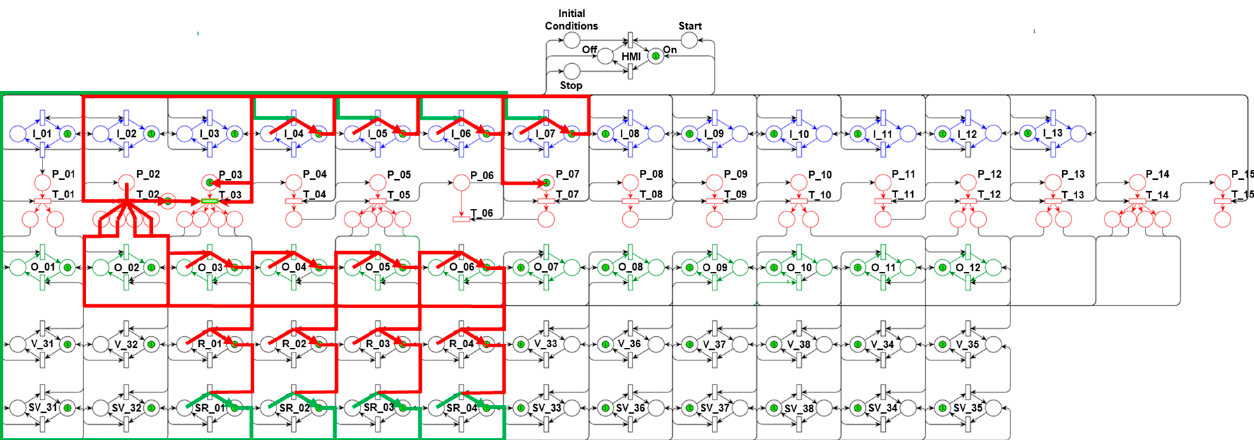
Figure 12. Algorithm’s third step—Activate regulators.